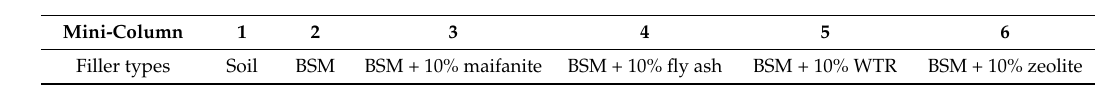
Table 1. Type of media in mini-column.